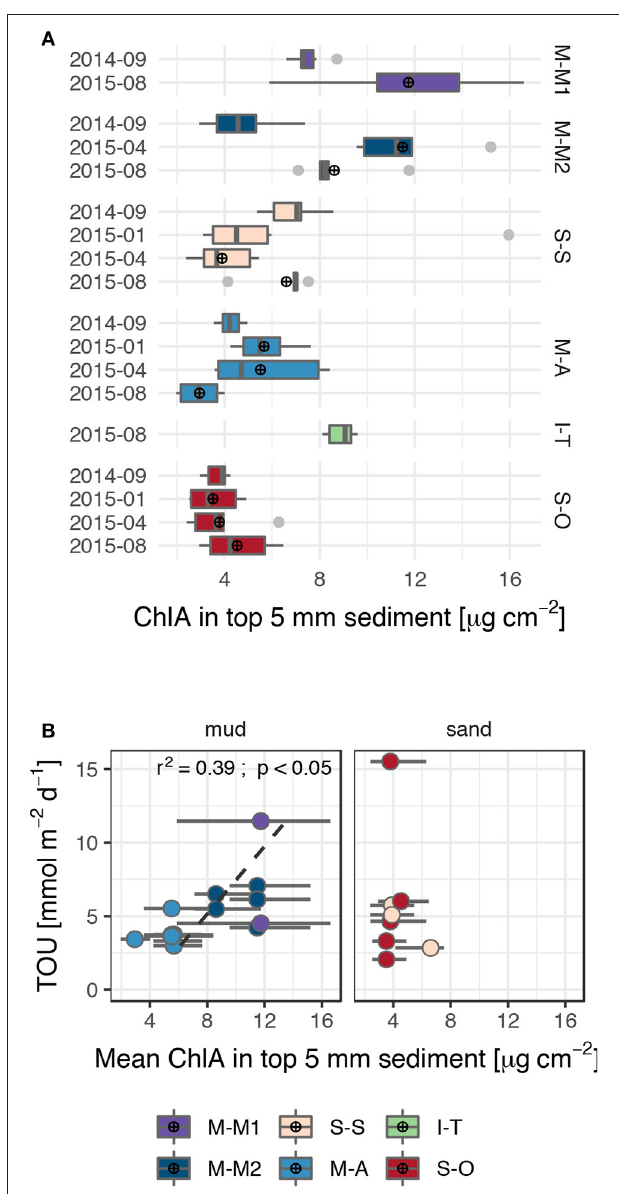
FIGURE 9 | (A) Chlorophyll a contents in the top 5 mm surface sediments. Each boxplot summarizes data from multiple sediment cores of one cruise. The left and right hinges of the boxes correspond to the 25 and 75th percentiles, the line within the boxes represents the median. The whiskers extend from the hinges to the largest and smallest value inside the 1.5-fold inter-quartile range. Arithmetic means of the groups used in (B) are marked by a ⊕ . (B) Total oxygen uptake rates vs. mean chlorophyll a contents in the top 5mm of the studied muddy and sandy sediments. Horizontal lines represent the range of values from which the arithmetic mean was